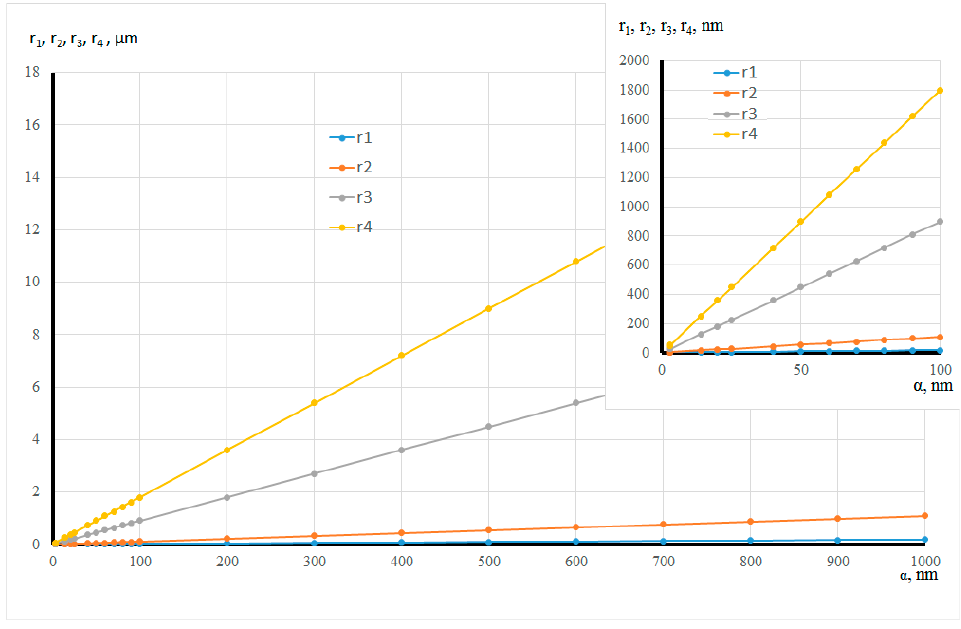
Figure 15. Dependence of the radius size of the four pore types on the globule radius. Table 1. Assessment of the radius size of the four pore types.